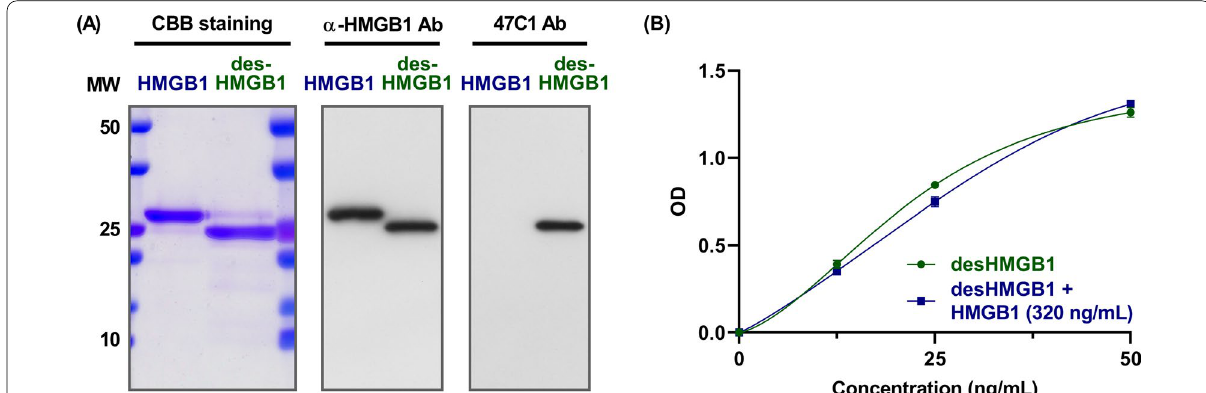
Fig. 3 Specificity of the monoclonal antibody 47C1. A Purified HMGB1 and desHMGB1 were subjected to SDS-PAGE followed by CBB staining (2 μg protein/lane) or western blotting (50 ng protein/lane). The anti-HMGB1 polyclonal antibody (ab 18256) detected both HMGB1 and desHMGB1, while the anti-desHMGB1 monoclonal antibody 47C1 specifically detected desHMGB1. B ELISA for desHMGB1 was constructed as described in “Methods” section. In this assay system, large amounts of intact HMGB1 (320 ng/mL) did not interfere with the detection of desHMGB1 (12.5–50 ng/ mL), indicating that the anti-desHMGB1 monoclonal antibody 47C1 did not interact at all with intact HMGB1